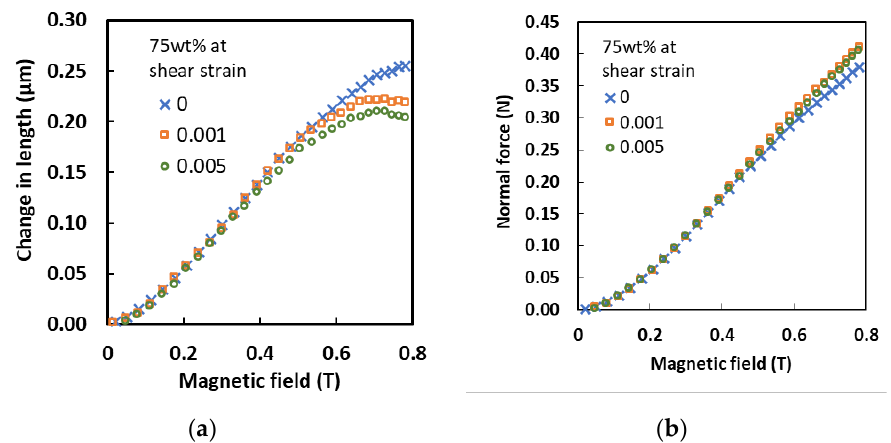
Figure 7. ( a ) Change in length and ( b ) normal force under various magnetic fields at different shear strains.